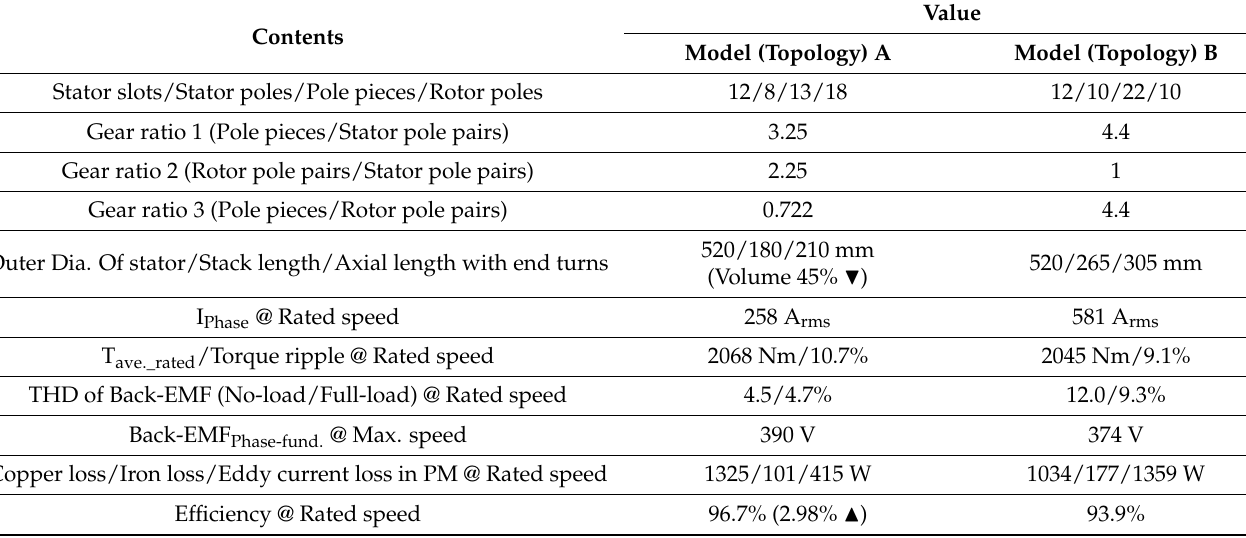
Table 5. Comparisons of 45kW-class MG-PMSM Design Models with Concentrated winding.